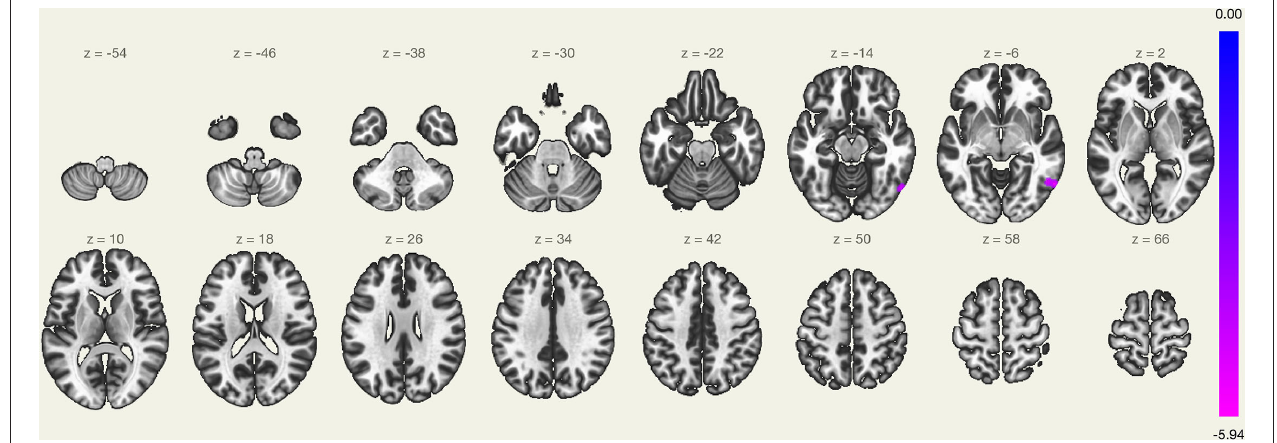
FIGURE 1 | Regions showing different functional connectivity with the locus coeruleus (LC) in the pre-transdermal trigeminal electrical neuromodulation (TTEN) and post-TTEN